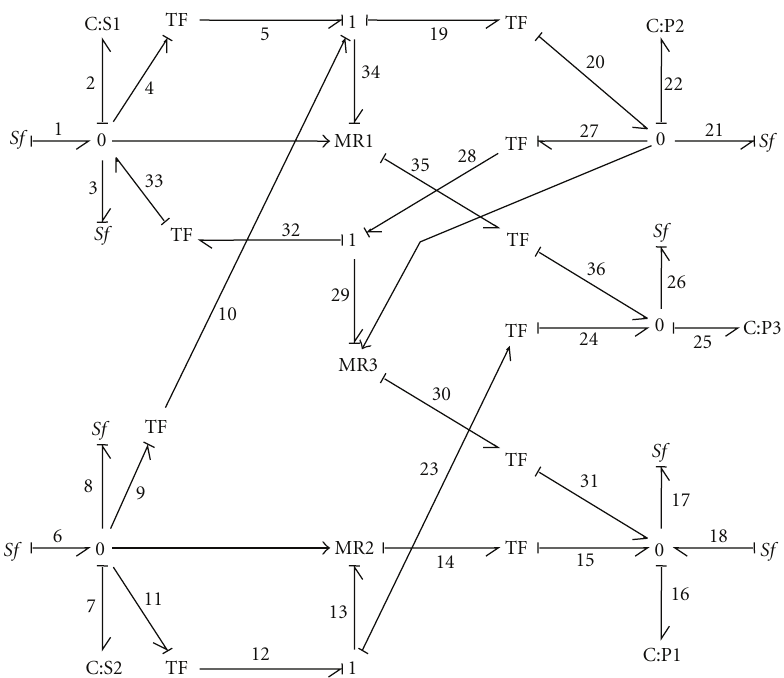
Figure 3: Bond graph model of the enzymatic synthesis of ampicillin. The directions of half arrows correspond to the run of the reaction, from the reactants towards the reaction products. The mass balances are represented by five 0-junctions, and the mass flows of entering/exiting components are modeled using modulated source flows Sf . The reaction rates are modeled by three modulated two port R elements, MR1, MR2, and MR3. In order to simplify the model representation, the feed flow and the volume are not shown. The bond graph model was depicted in 20 sim